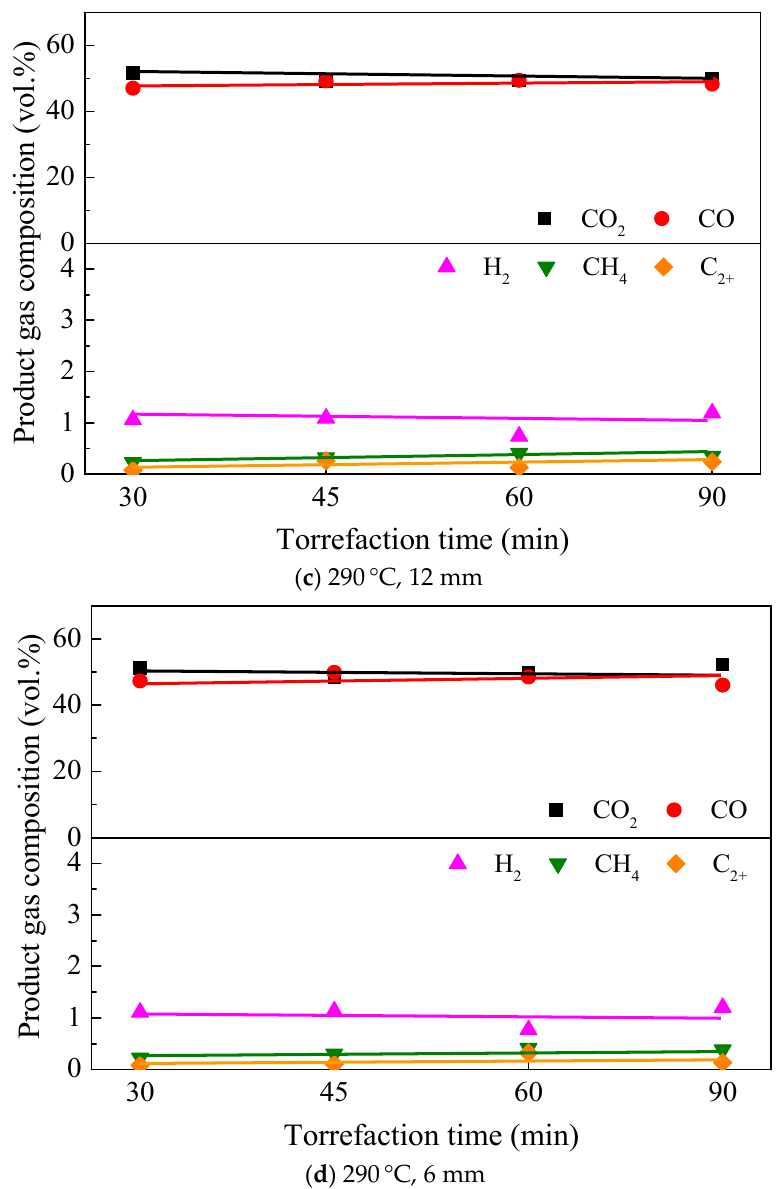
Figure 5. Product gas composition of Paulownia wood torrefaction at 260 and 290 °C under different torrefaction times. Table 2. Effect of particle size on the chemical composition, higher heating value, and energy yield of the solid product of Paulownia wood torrefaction under different torrefaction